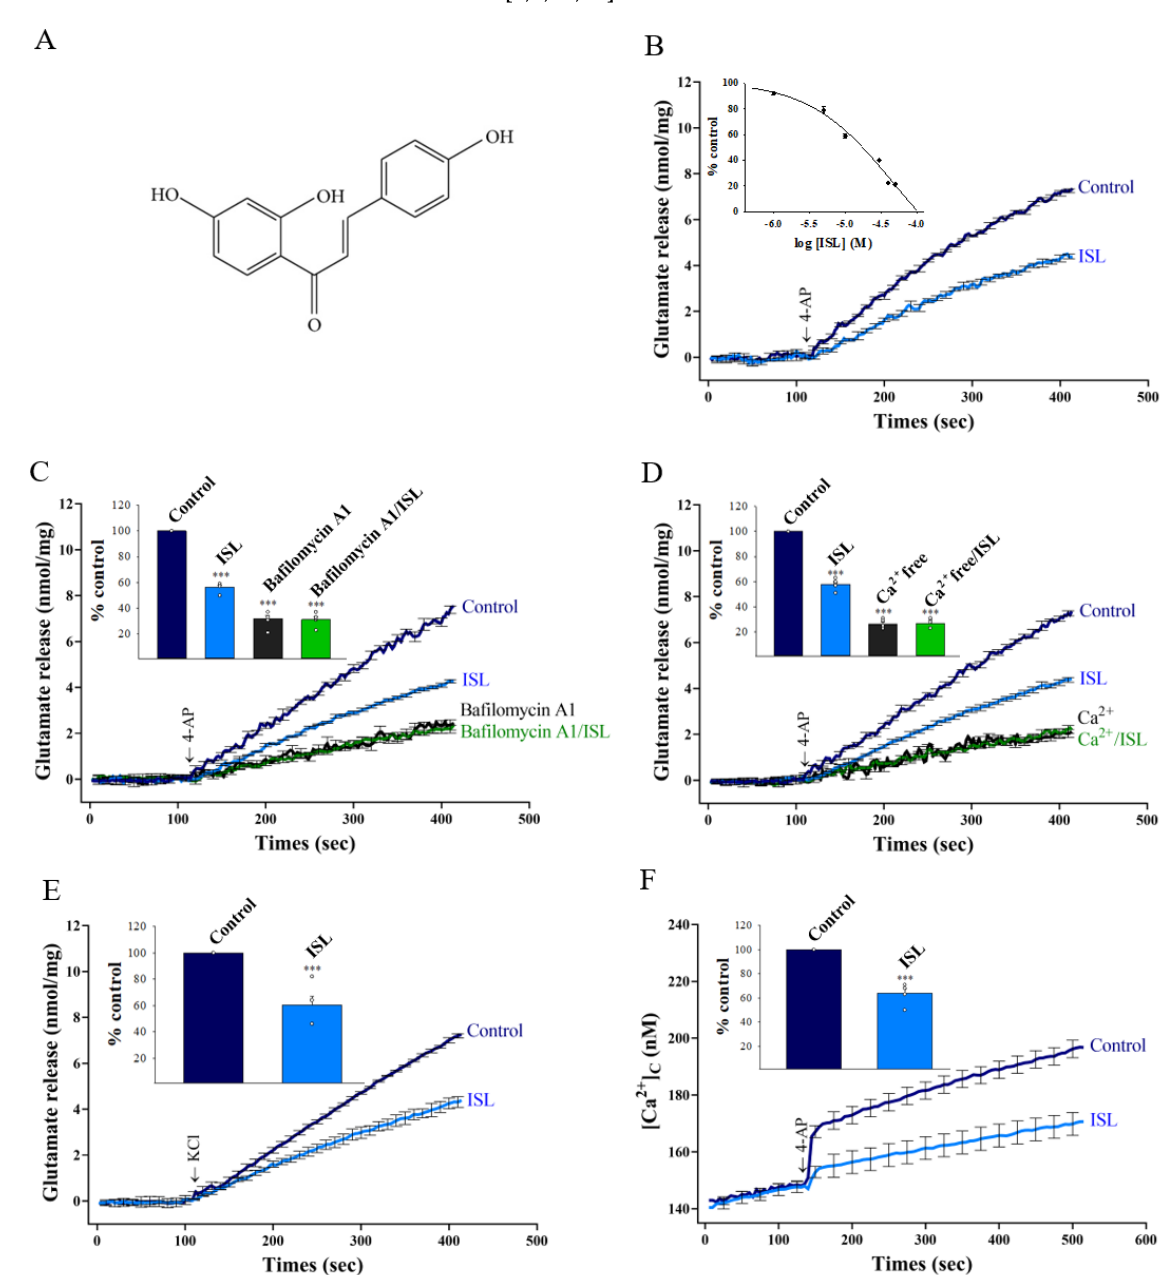
Figure 1. ISL inhibits 4-AP-evoked glutamate release and Ca 2+ influx from rat cerebrocortical synaptosomes. ( A ) The chemical structure of ISL. ( B ) 4-AP-evoked glutamate release from synaptosomes incubated in the presence of 1.2 mM CaCl 2 , and in the absence (control) or presence of ISL. Inset show dose-response curve of decreases in 4-AP-evoked glutamate release in the presence of ISL (% control release 5 min after 4-AP addition). ( C ) 4-AP-evoked glutamate release from synaptosomes incubated in the presence of 10 µ M ISL, 0.1 µ M bafilomycin A1, or both (bafilomycin A1/ISL). Inset compares decreases in 4-AP-evoked glutamate release by ISL, bafilomycin A1 or ISL and bafilomycin A1 (% control release 5 min